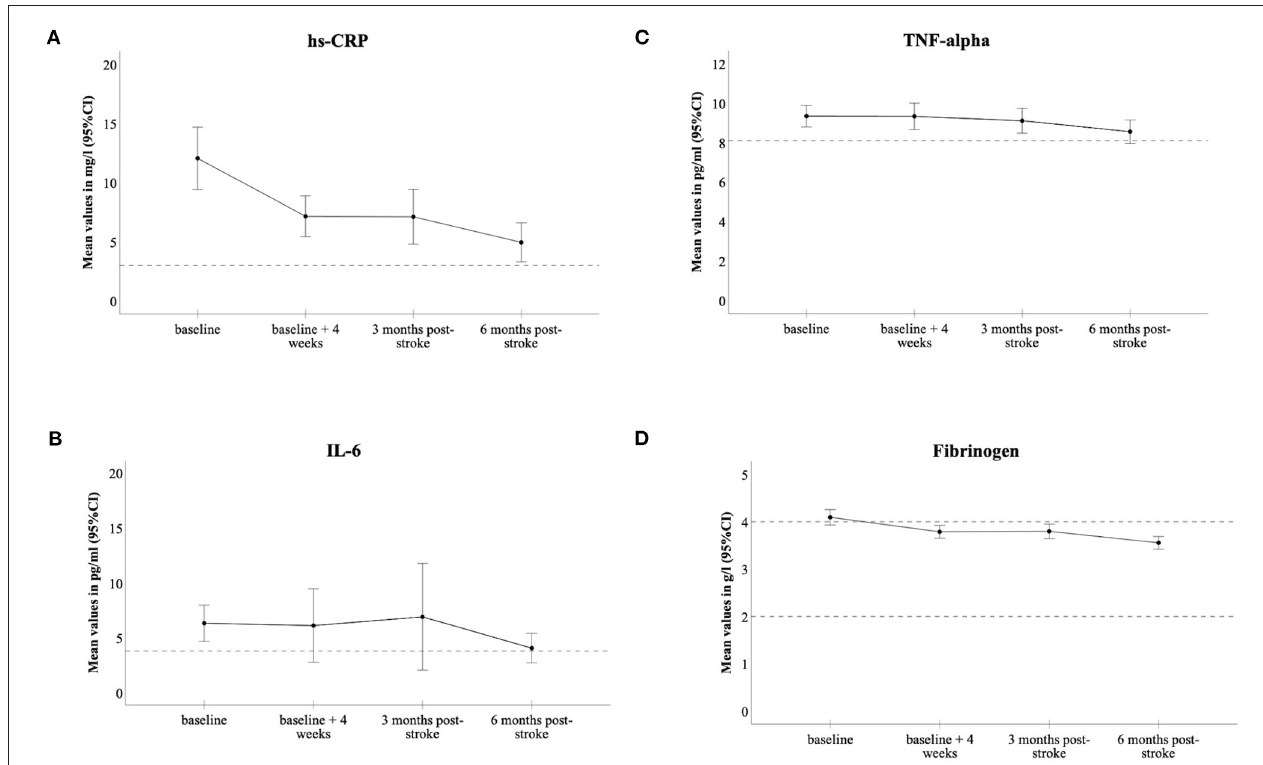
FIGURE 1 | Dynamics of inflammatory biomarkers in the PHYS-Stroke study cohort; hs-CRP (A) , IL-6 (B) , TNF-alpha (C) , fibrinogen (D) . Levels of markers are expressed as means, 95% CIs as error bars; horizontal dashed lines depict cut-off for normal ranges.